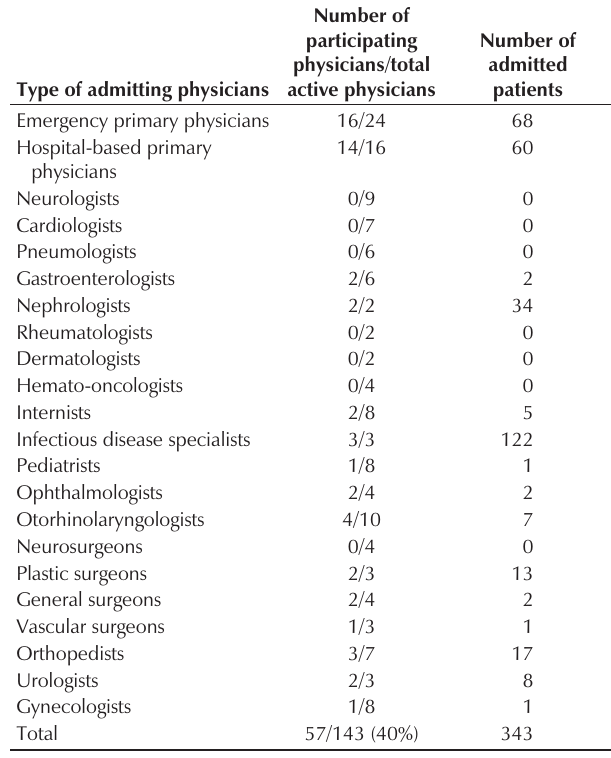
Participation of active medical/surgical staff at Hôpital Charles LeMoyne in the outpatient antibiotics program